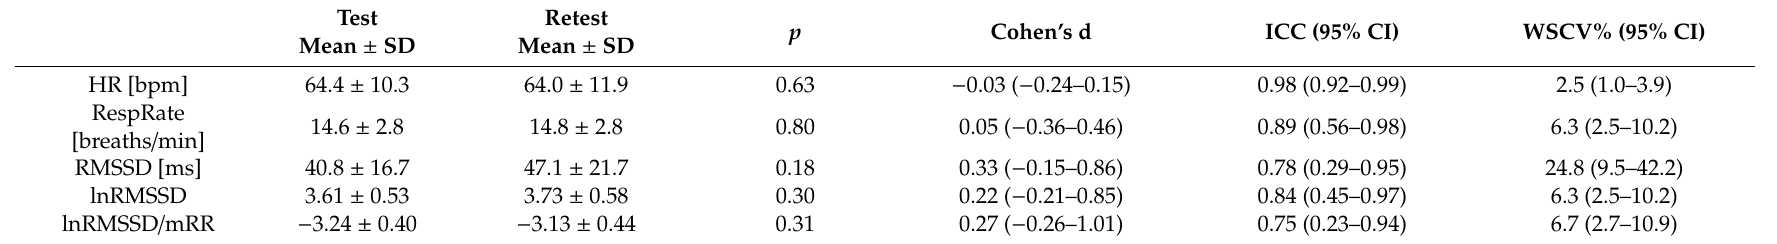
Table 2. Reliability results for ultra-short-term (1 min) HR, RespRate and RMSSD